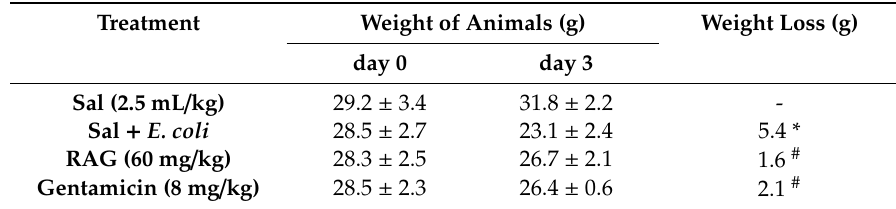
Table 6. E ff ects of red angico gum (RAG, 60 mg / kg, p.o.) in decreasing body weight on Escherichia coli induced diarrhea in mice.